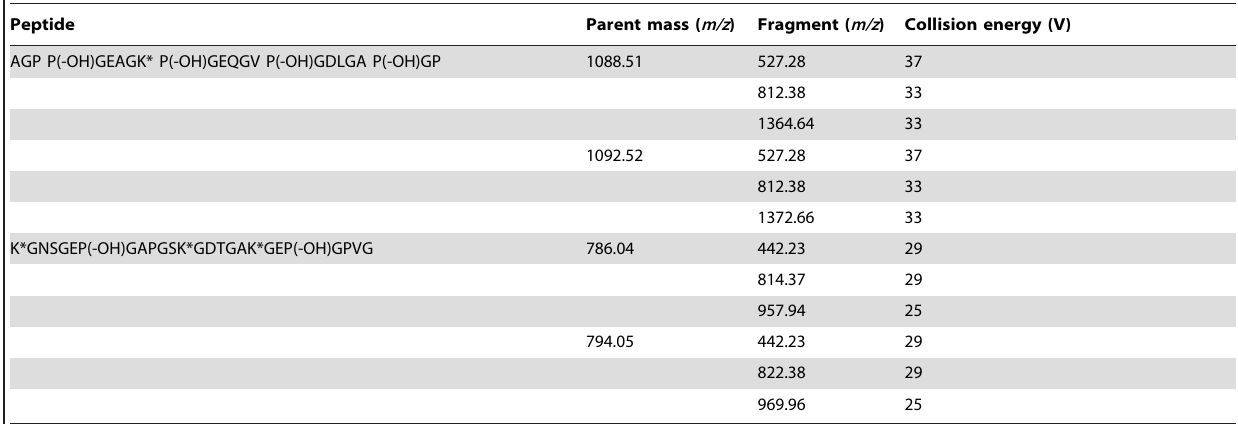
For each stable isotope labeled amino acid an extra mass of 8 Da is included. m/z (mass-to-charge ratio); V